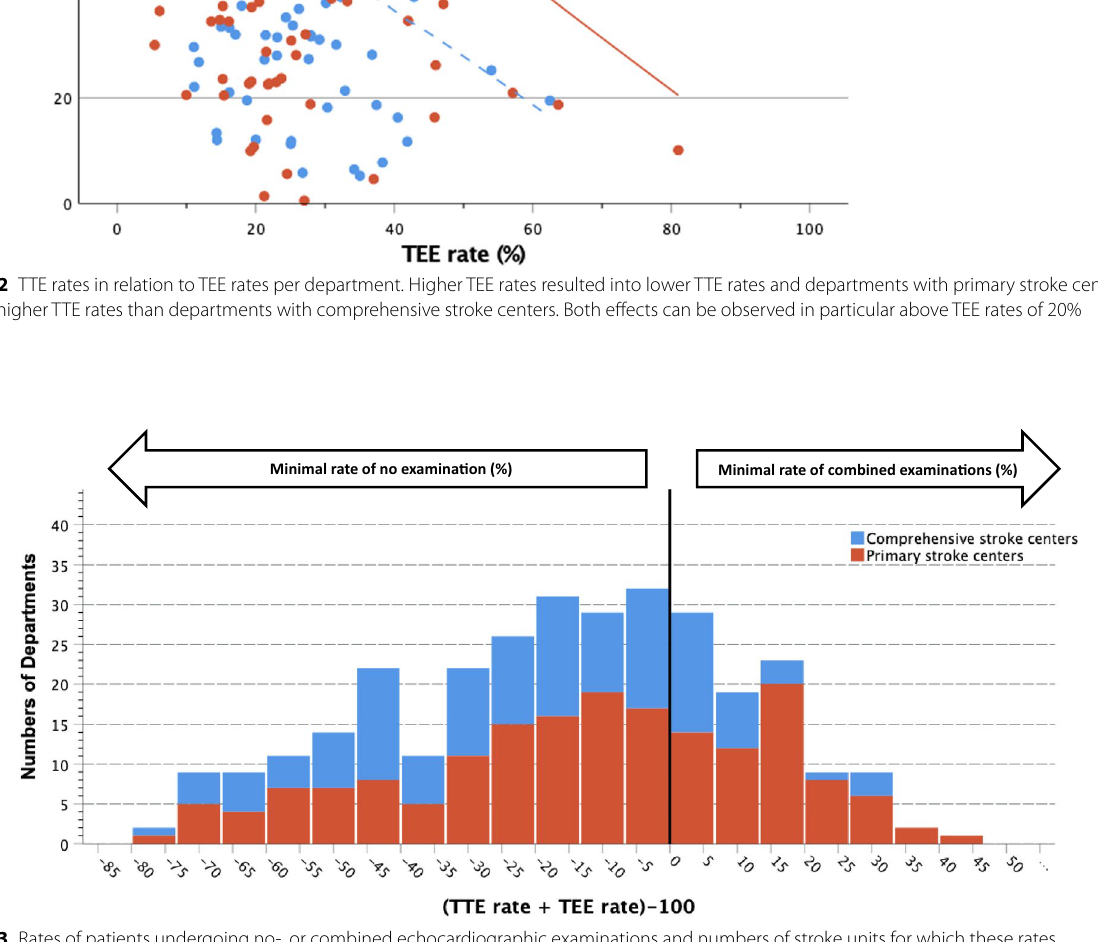
departments with pSCs: OR 0.003; p 0.230). =